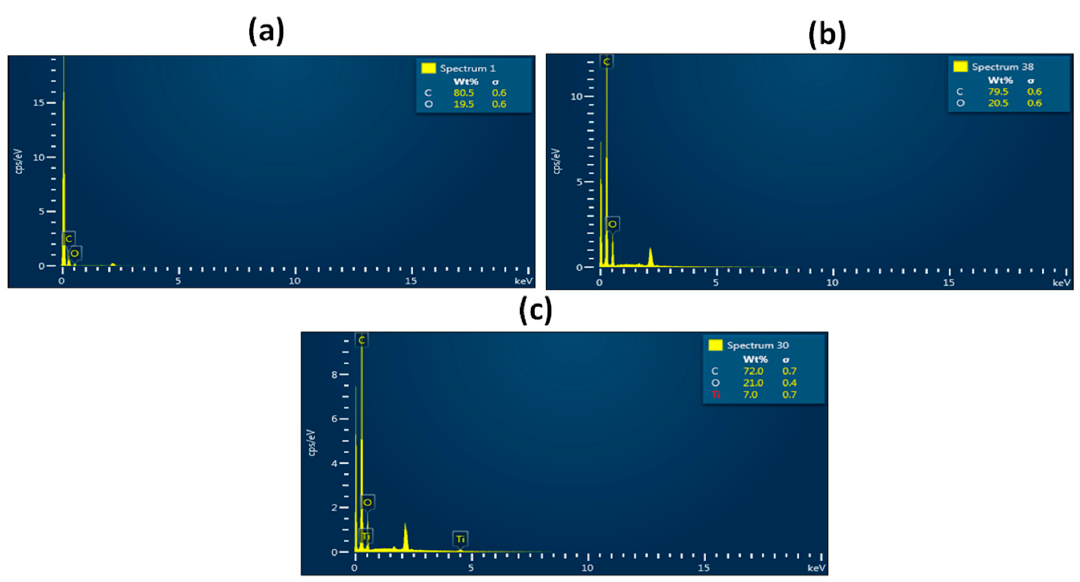
Figure 3. EDX of a ) PU, b ) PU/BASIL and c ) PU/BASIL/TiO 2.